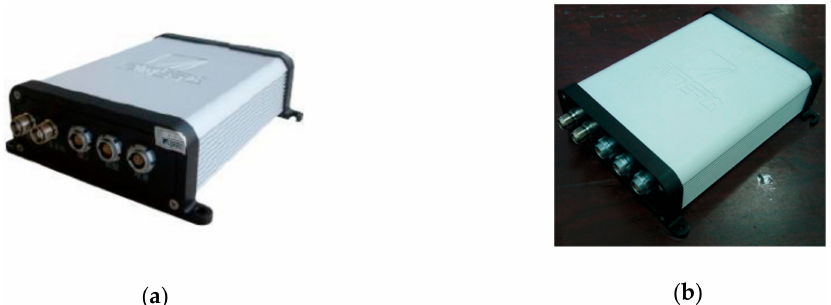
Figure 3. BeiDou Navigation Satellite System (BDS) used in this study: ( a ) The XW-GI 5630 mobile station; ( b ) The XW-GNSS 1060 base